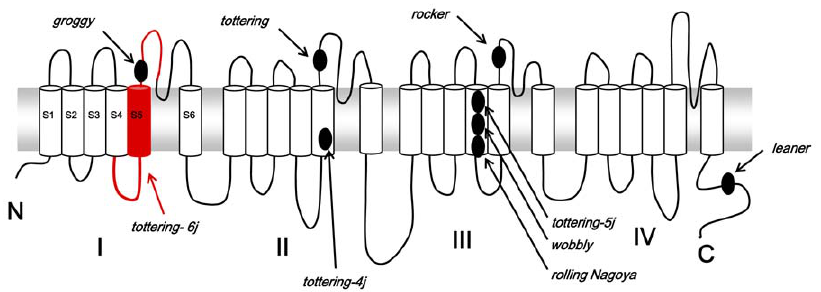
Figure 5. Proposed transmembrane topography of the Cav2.1 a 1 subunit and positions of known mutations identified in the Cacna1a mutant mice and rat. The deletion region including part of the S4–S5 linker, S5, and a part of S5–S6 in domain I of Cav2.1 a 1 in the tottering-6j mice is shown by the red line.